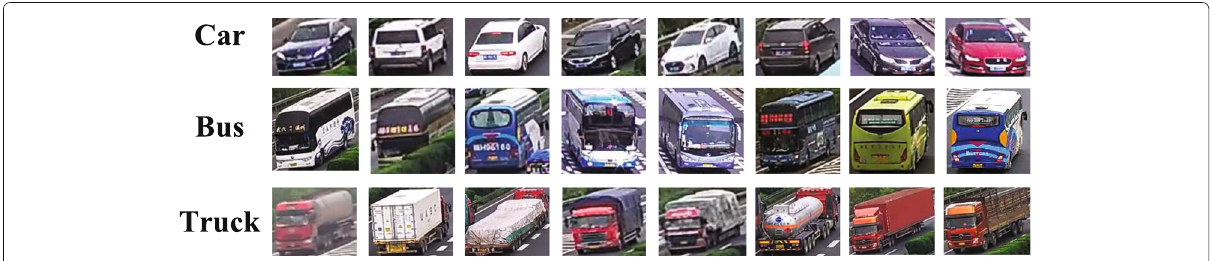
Fig. 2 Vehicle labelling category of the dataset